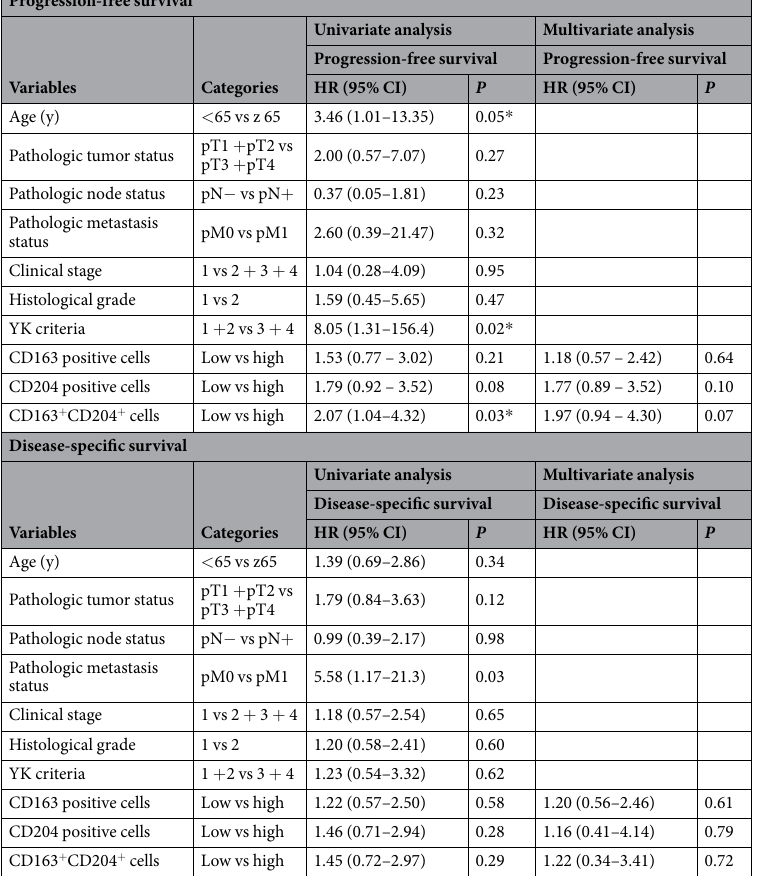
expression is limited to macrophages and DCs 35 . In malignant tumor, TAMs suppressed anti-tumor immune responses by overexpression of PD-L1/2 36 . Therefore, further examinations are required to elucidate the expres- sion of PD-L2 in each TAM subsets in OSCC. We next examined the association of the TAMs with the prognosis of OSCC patients. The number of CD204 + and CD163 + CD204 + TAMs in OSCCs was positively correlated with clinical T classification and distant metas- tasis. Moreover, the numbers of CD163 + CD204 + TAMs also significantly associated with the progression-free survival curves. However, the association between the expression of TAM markers and clinical prognosis for cancer patients remains controversial. Hirayama et al . 37 reported that a high number of CD204 + TAMs in lung SCCs was significantly correlated with advanced clinicopathological parameters and poor prognosis. Another study showed that there was no significant difference in clinicopathological factors and clinical prognosis between high and low expression groups of CD163 + TAMs in OSCC 38 . These results were consistent with our results in the present study. On the contrary, in gliomas, both CD204 + and CD163 + TAMs were positively cor- related with the histological malignancy 39 . This contradictory conclusion may be due to different tumor types or methodologies. In conclusion, we have confirmed that CD163 + CD204 + TAMs promote T-cell apoptosis and immunosup- pression via IL-10 and PD-L1 and predict unfavorable prognosis in OSCC patients. We are currently examining which of the TAM subsets contribute to the tumor proliferation and angiogenesis in OSCC. A more thorough understanding of the role of each TAM subset could lead to the development of novel pharmacological strategies aimed at disrupting TAMs or their products and inhibiting the progression and/or metastasis of OSCC.